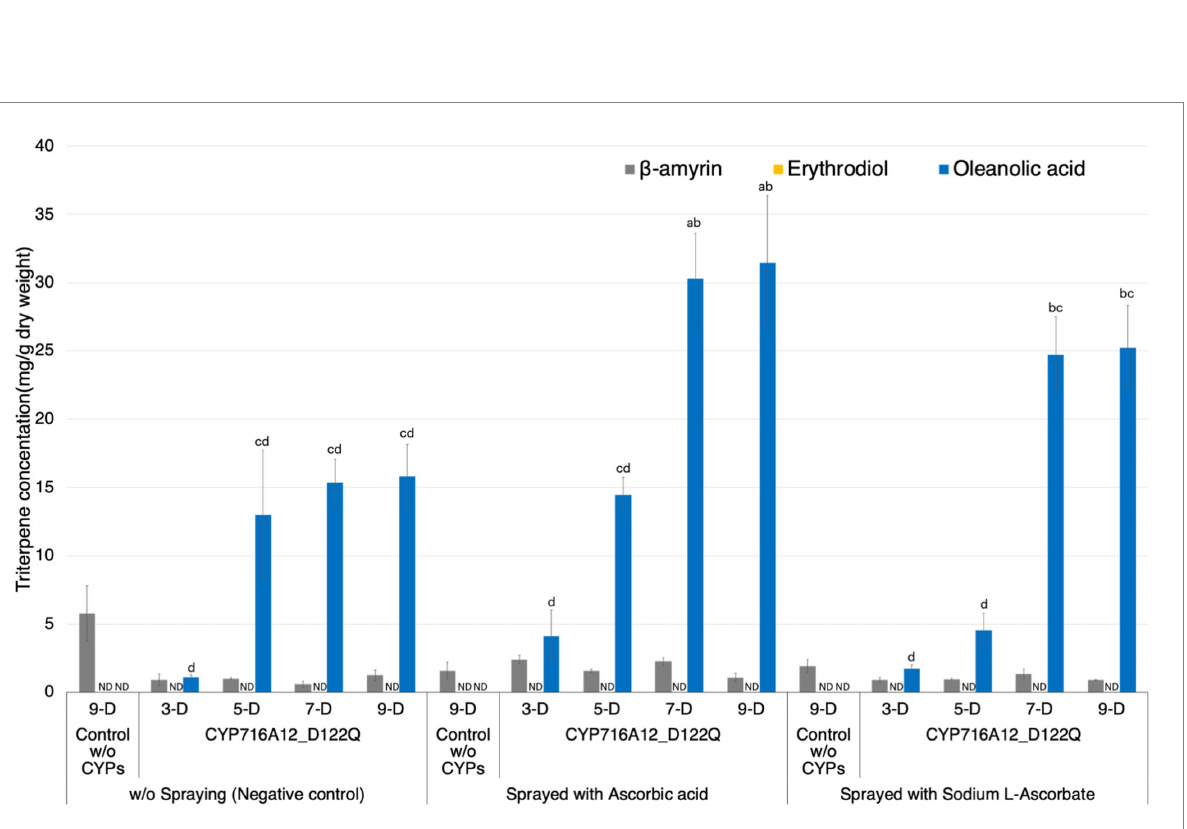
FIGURE 3 Improving production of oleanolic acid in Nicotiana benthamiana leaves by application of ascorbic acid. Quantification of triterpene concentration in N . benthamiana leaf extracts transiently expressing a combination of LjOSC, LjCPR2, and CYP716A12_D122Q or pBYR2HS empty vector (control) with or without foliar application of 200 mM ascorbic acid or ascorbic acid sodium salt (sodium l -ascorbate). Metabolites were extracted from leaves at 3, 5, 7, or 9 days after agroinfiltration. A combination of pBYR2HS expressing LjOSC, LjCPR2, and empty vector was used as a background control (9 days). Values and error bars represent the mean and standard deviation and the data are representative of at least three biological replicates ( n = 3). Letters indicate significant differences in the levels of oleanolic acid (a–d) among samples (one-way ANOVA with Tukey’s post-hoc test, p < 0.05). ND, not detected.